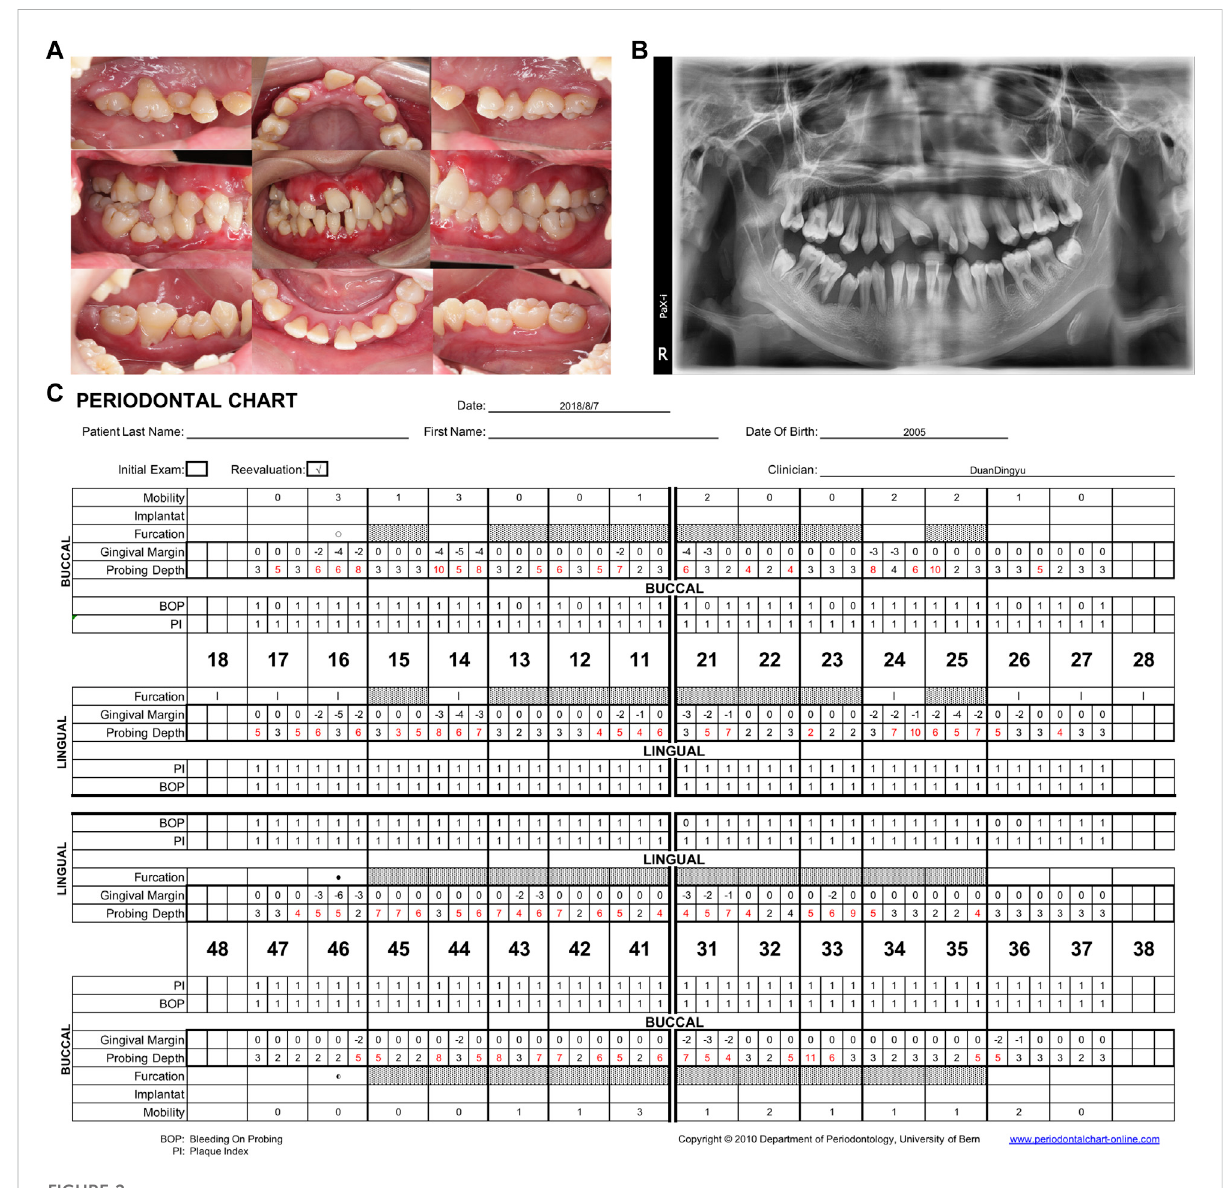
FIGURE 2 Follow-up examination in 2018. (A) Intraoral view showing redness, gingiva swelling and recession, irregular tooth alignment, and serious occlusion disorder. (B) Panoramic radiograph showing generaldisappearance of thelamina dura and complete horizontalabsorptionof thealveolar bone to 1/2 – 2/3 of the root length. The alveolar bone loss of 14, 16, 24, 25, and 46 involved the apical roots. (C) Periodontal chart. 93% bleeding on probing, mean PD: 4.2 mm. PD, probing